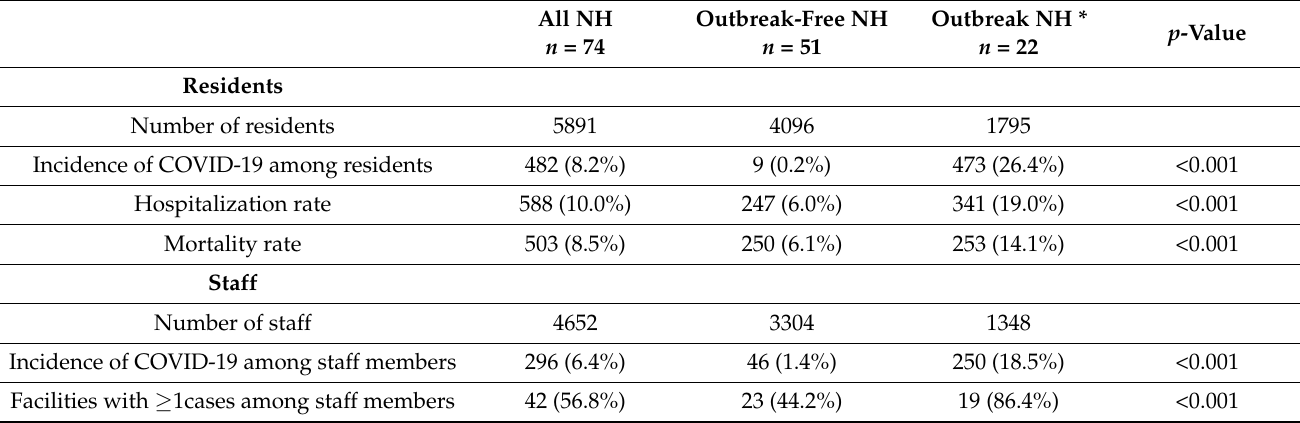
Table 2. Number of cases and incidence of COVID-19 among residents and staff members, overall, in outbreak and in outbreak-free nursing homes.